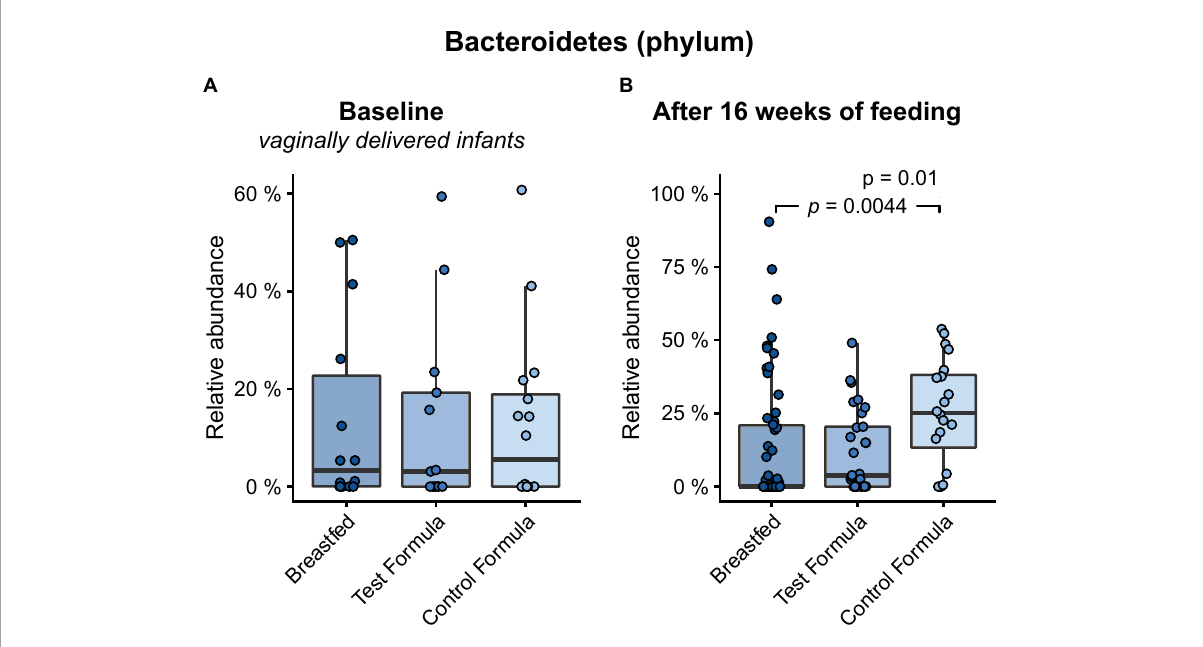
FIGURE3 Box plots of the relative abundance of Bacteroidetes at baseline in vaginally delivered infants (A) and after 16 weeks of feeding in infants (B) in the breastfed, test formula, or control formula-feeding group. Horizontal lines indicate the median; box boundaries indicate the interquartile range; whiskers represent values within 1.5 × the interquartile range of the first and third quartiles. Statistics: Mann–Whitney U -test. P -values are shown when Q (FDR) < 0.1.